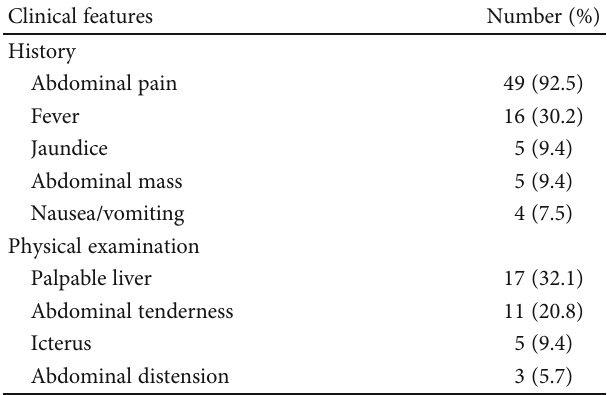
Table 2: Clinical features in the study population.